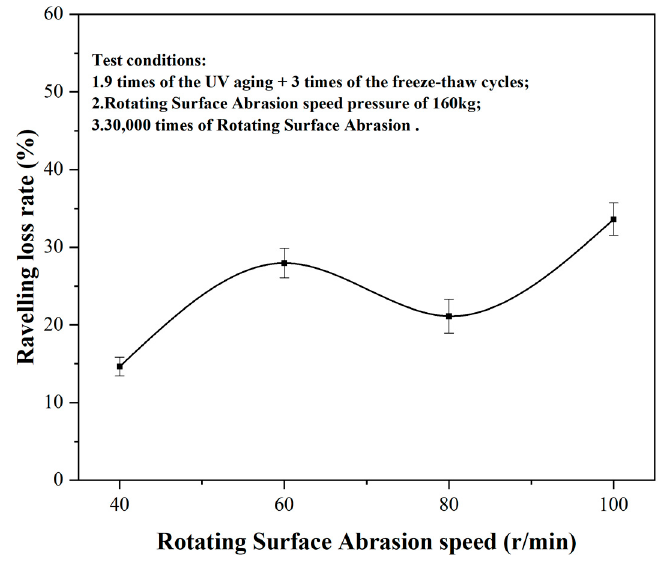
Figure 8. Simulated vehicle speed impact test.